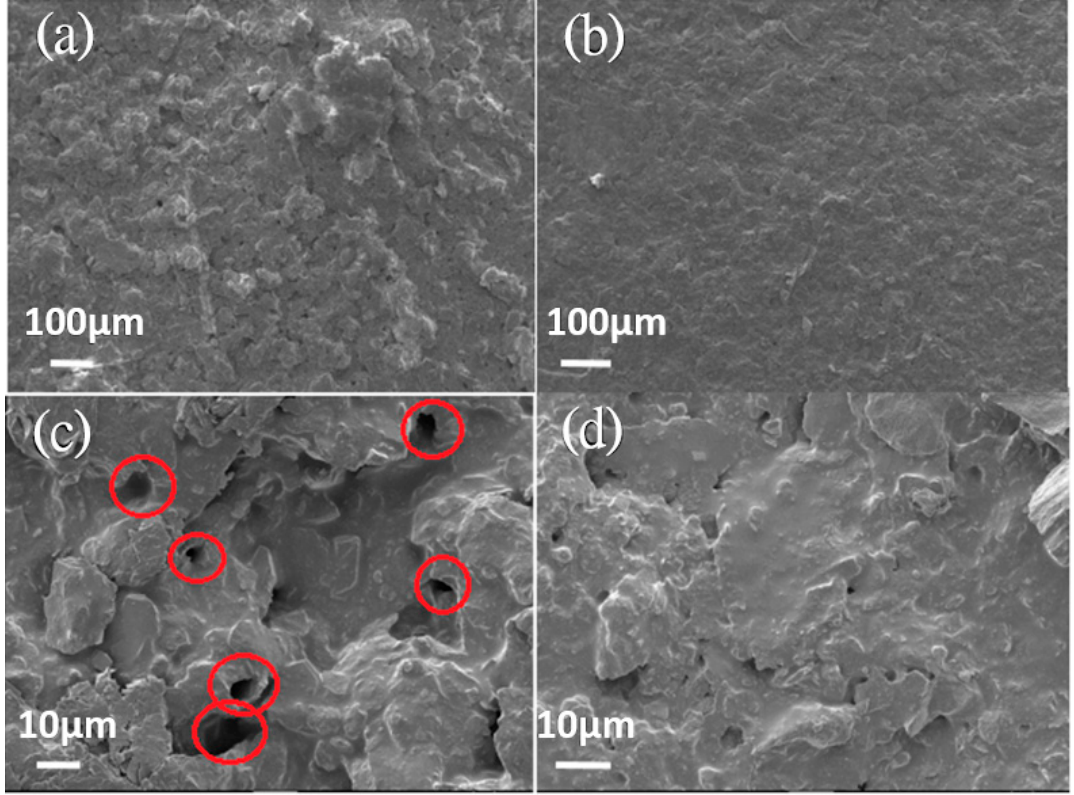
Figure 6. SEM images of the surface morphology for the coatings ( a ) without and ( b ) with GN fillers. ( c , d ) are the high-magnification images for ( a , b ), respectively.